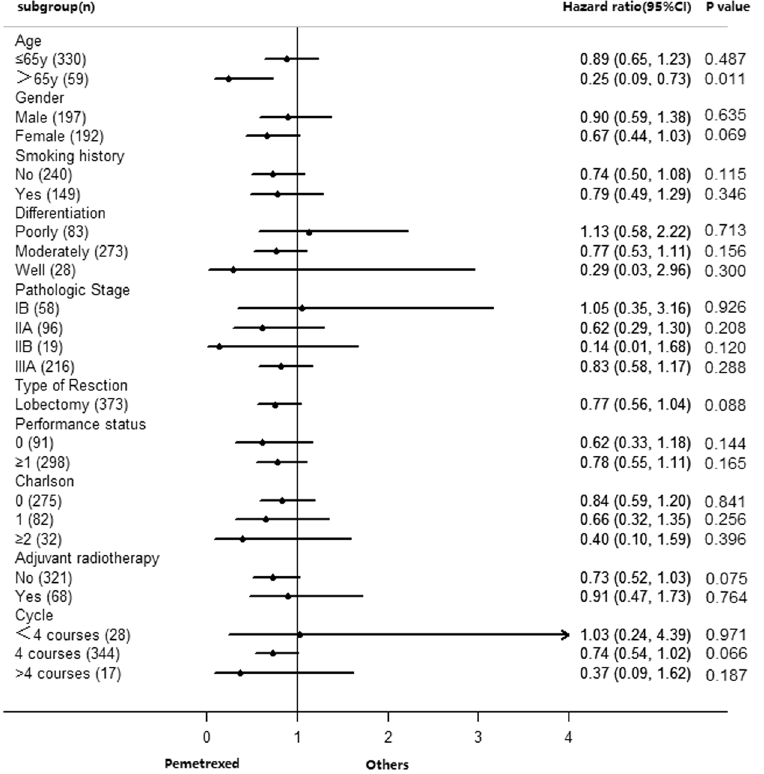
Figure 3. Subgroup